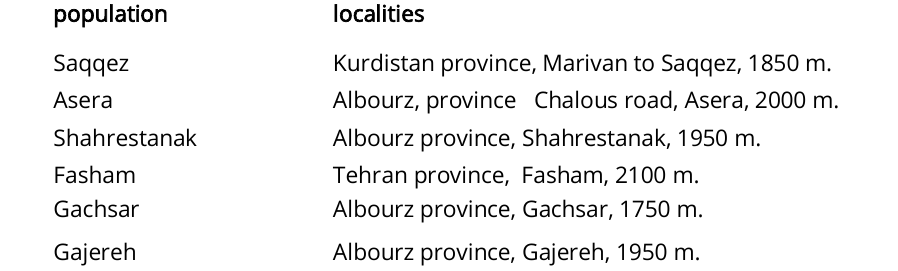
Table1. Populations studied their locality and their localities